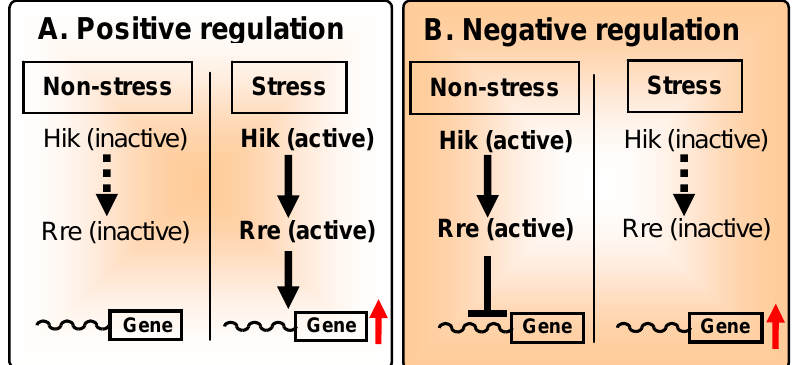
Figure 2. Schematic representation of positive (A) and negative (B) modes regulation of stress-inducible expression of genes. Solid arrows indicate signals that activate downstream components and dotted arrows indicate their absence. The inverted ‘T’ indicates signals that repress the expression of downstream genes. Red arrows correspond to the enhancement of gene expression. Adopted from [28]. Published with permission of Horizon Scientific Press / Caister Academic